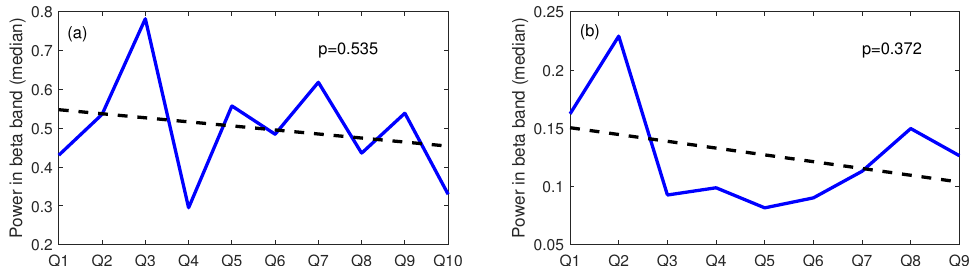
Figure 9. The stress-inducing events over time; ( a ) Task A, ( b ) Task B; Q: Question; blue line: beta power for each question, dotted line: linear